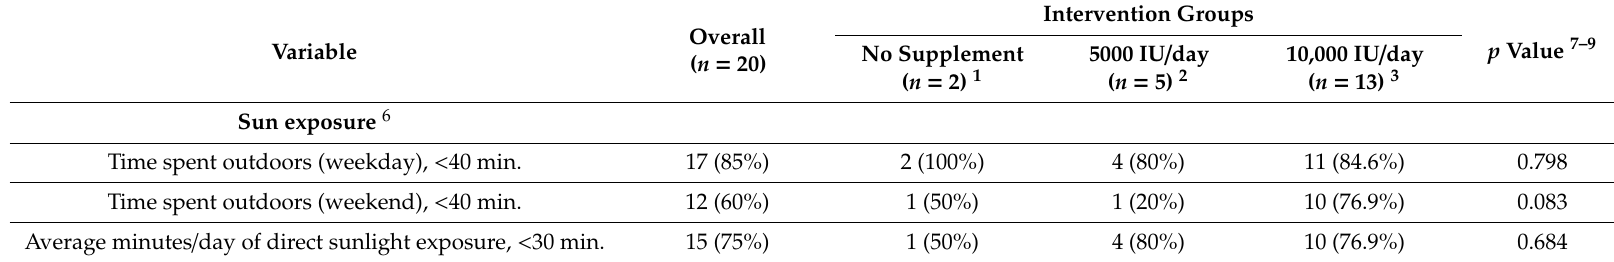
Intervention Groups